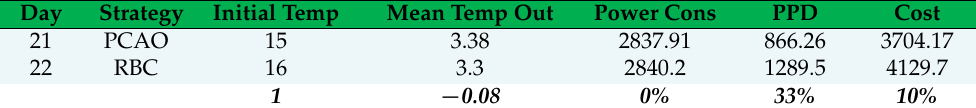
Table 12. Comparison between the PCAO (21st) and RBC (22nd) winter days.